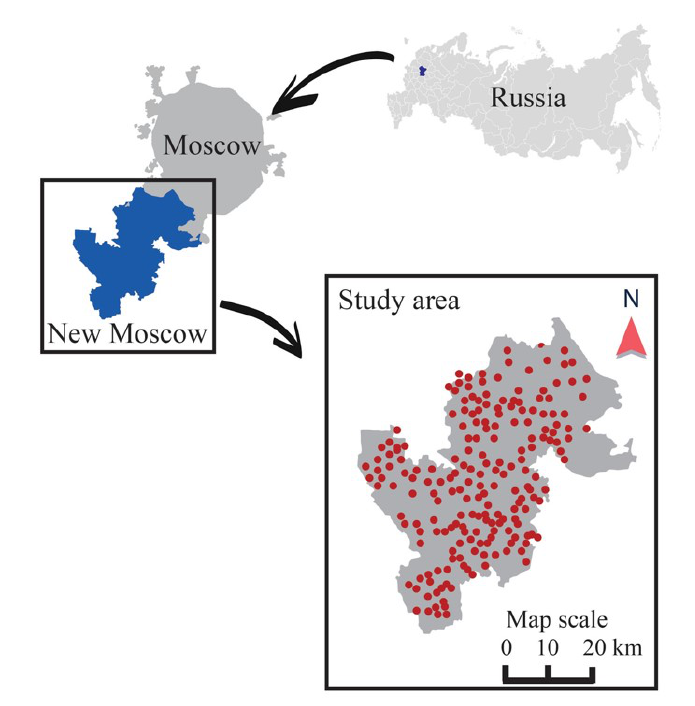
Figure 1. Study area: territory of New Moscow. Red points correspond to the water sampling locations considered in the research. The dataset consists of 1182 water sampling points allocated in wells. For each point 25 parameters of chemical properties are